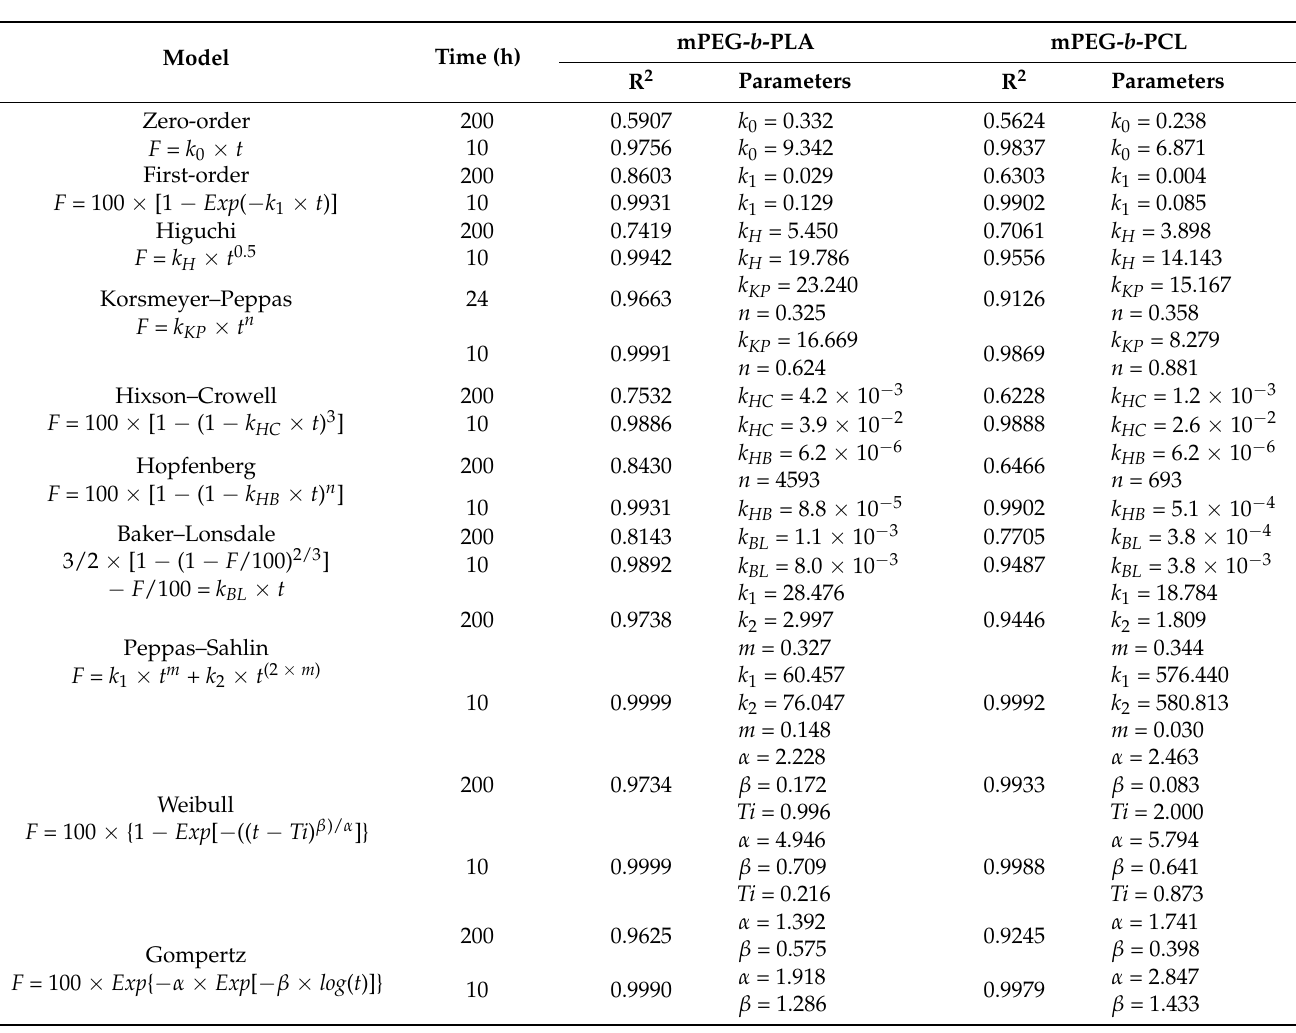
Table 4. Correlation coefficients and model parameters obtained for DOD release profiles of mPEG- b - Table 1. Effect of polymerization temperature and time of reaction on the yield and molecular PLA and mPEG- b -PCL weight of synthesized (co)polymers. Conditions: PLA and mPEG- b -PLA synthesis, [D,L-